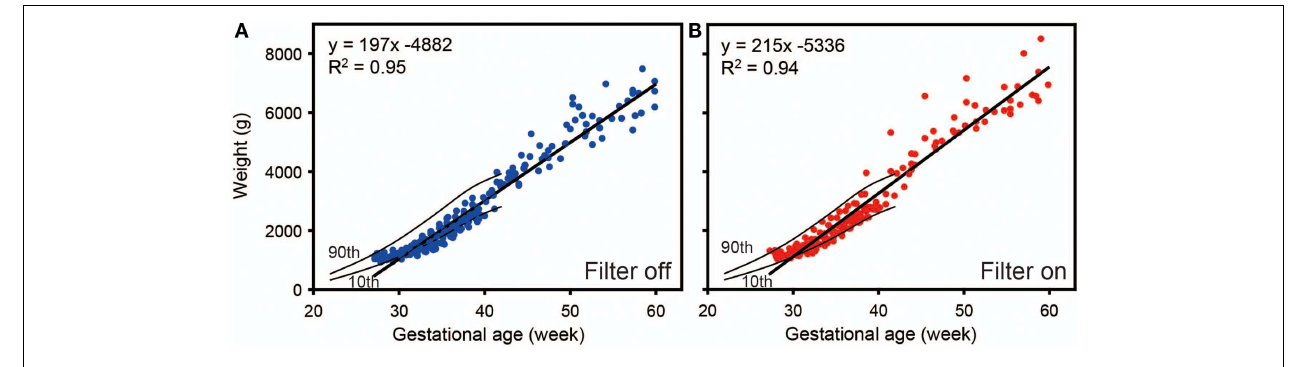
equation for repeated measures. Data from 20 control and 19 experimental group infants.Tenth and ninetieth centile curves of birth weights from 22 to 42weeks’ gestational age were also drawn in the figures